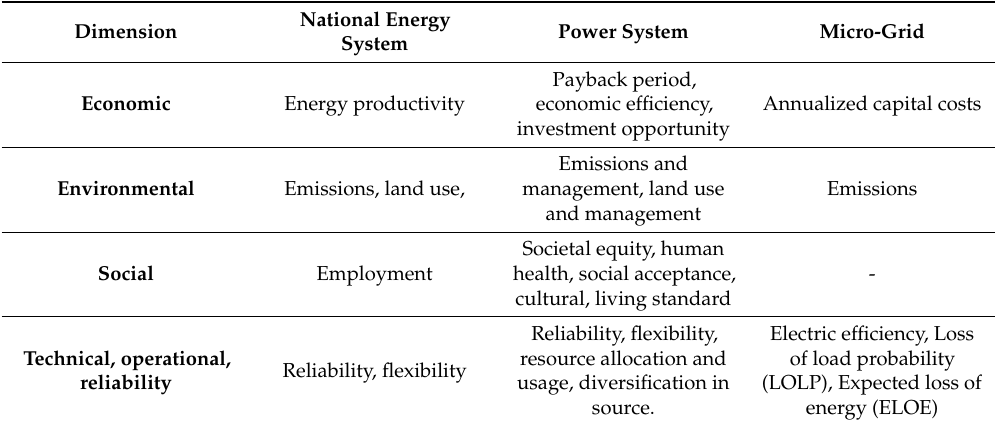
Table 6. Examples of sustainable development criteria of power system applications at different levels